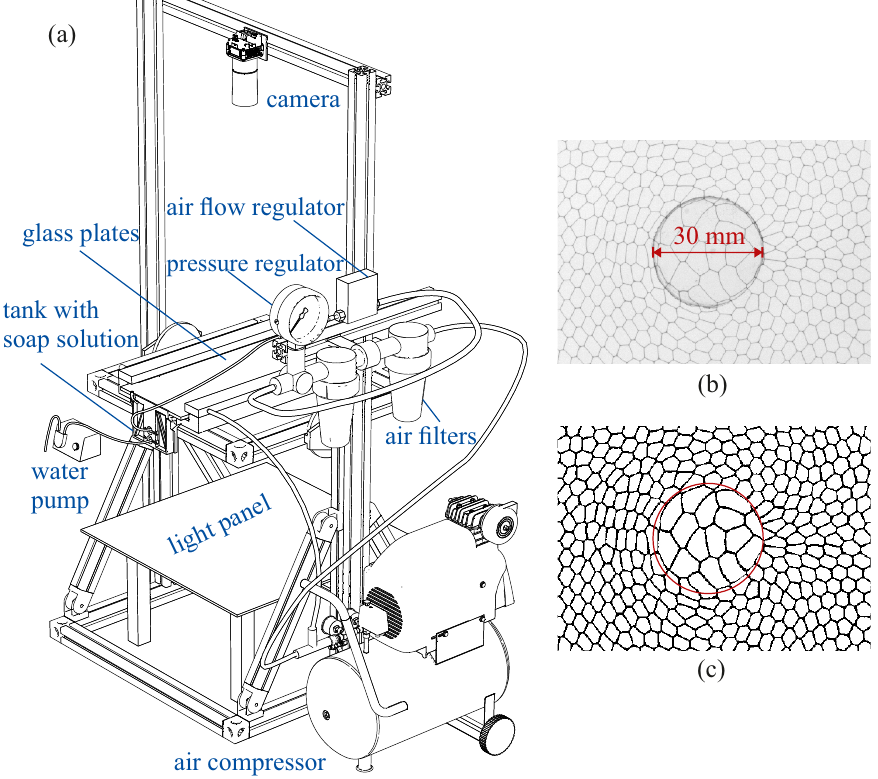
Figure 1. ( a ) Experimental setup: a Hele-Shaw cell consisting of two glass plates with a gap of G = 1.15 mm, the tank (in situ foam generator) attached to the bottom plate with holes for air and fluid injection, the light source below the cell and the camera above it; the air from the compressor is partially used for pressing the glass plates; compressed air passing filters enters the air flow regulator and the tank via the needle. The water pump controls the soap solution flow rate. ( b ) Raw image of the foam flow zoomed in on the permeable obstacle area (obstacle diameter a = 30 mm) and ( c ) its binarization, with the red circle corresponding to the position of the permeable